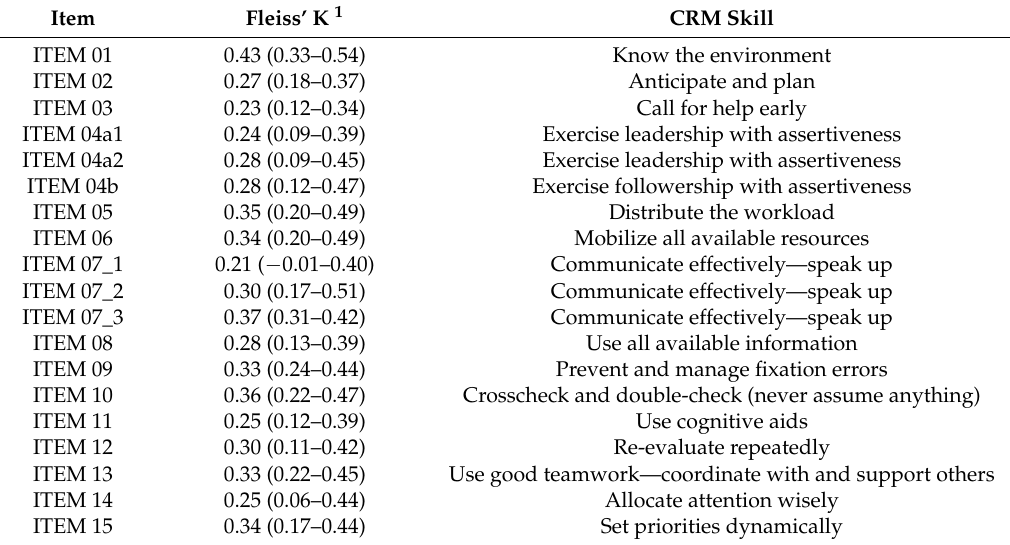
Table 4. Inter-rater agreement for each item (N =